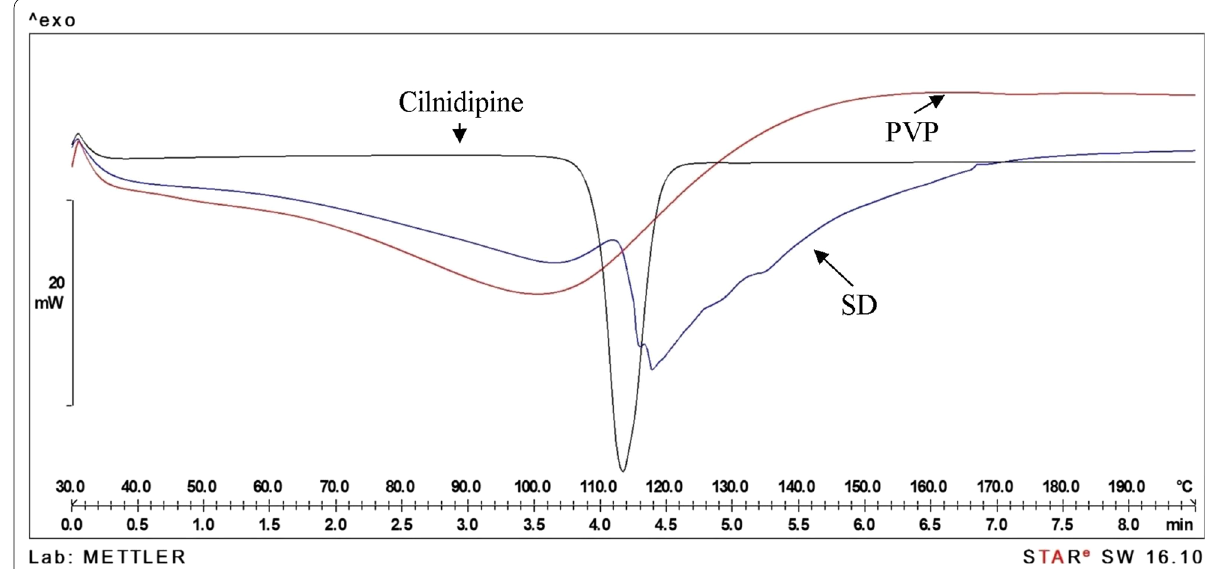
Fig. 6 a Differential scanning calorimetry report of cilnidipine, PVP, and SD